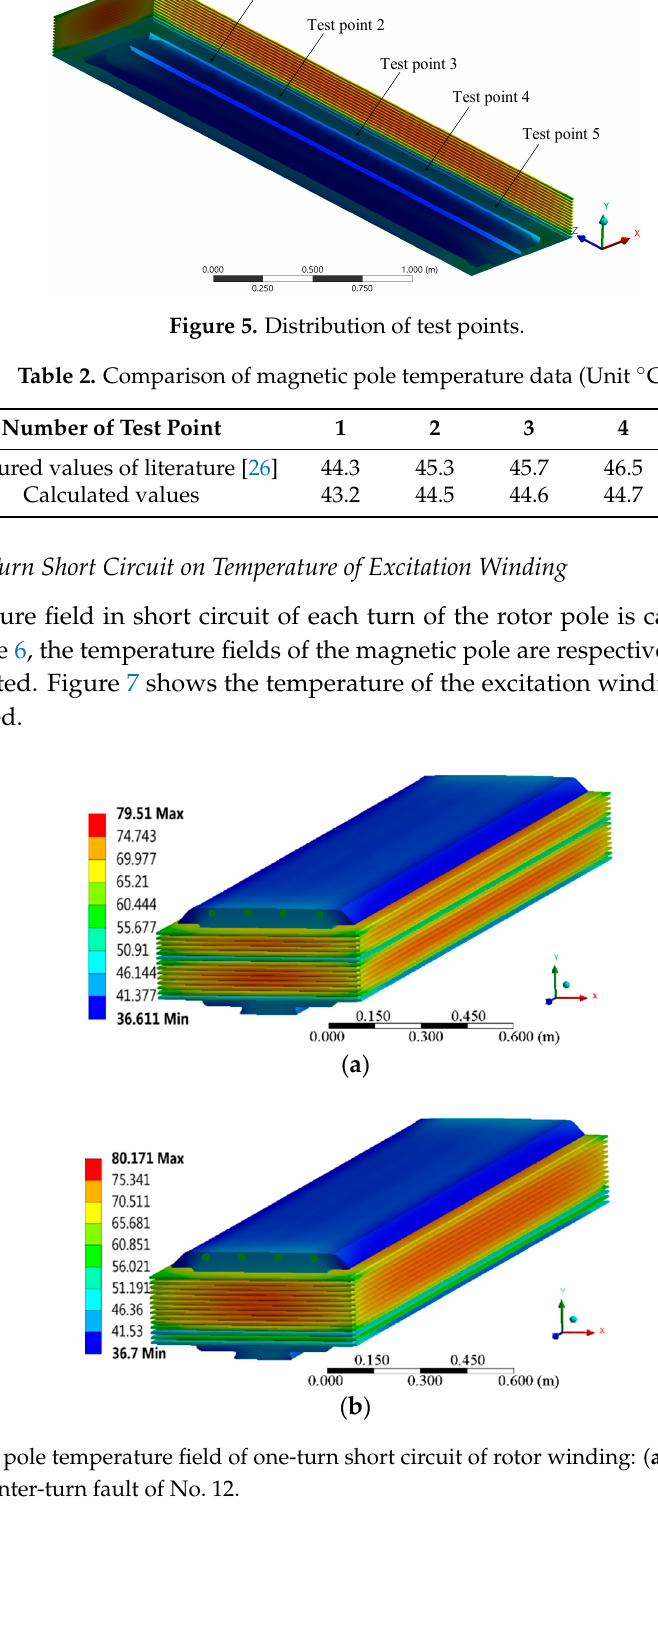
Figure 5. Distribution of test points. Table 2. Comparison of magnetic pole temperature data （ Unit ° C ）